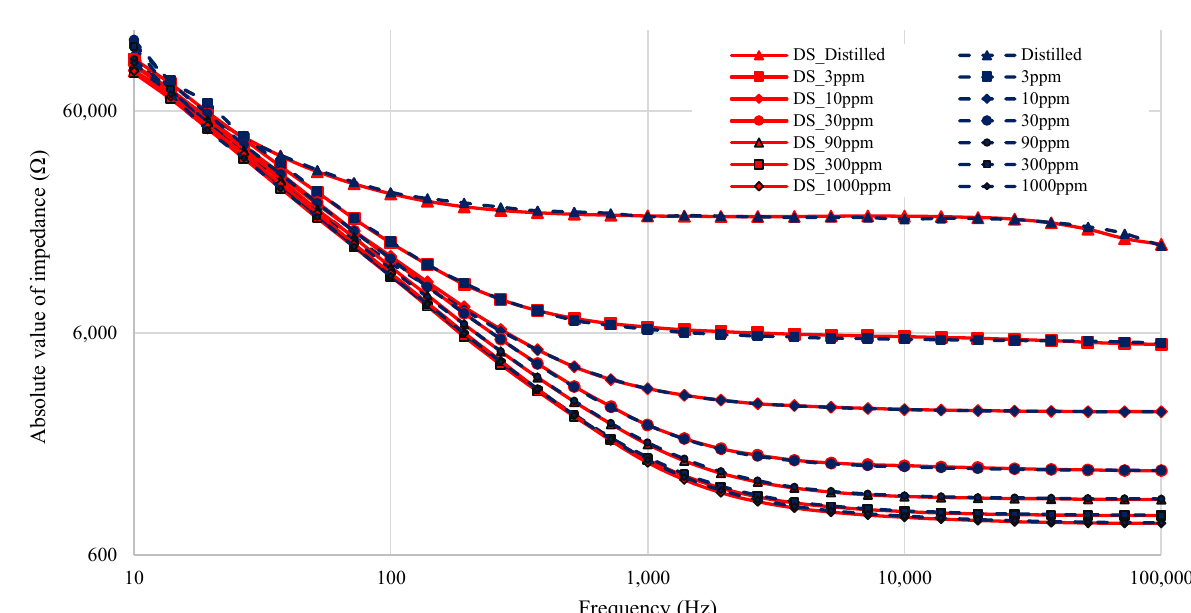
Figure 9. Figure showing magnitude of impedance of all seven solution measurements after calibration. All DropSens µStat-i 400s measurements are in red, with low-cost impedance measurements in blue.